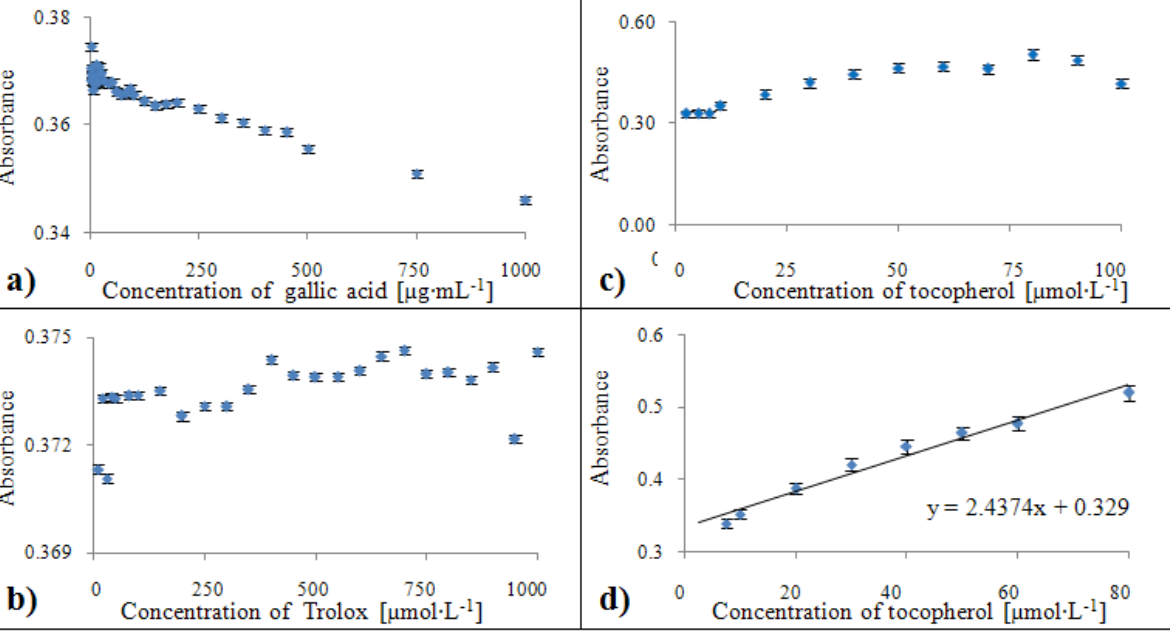
method related to 5